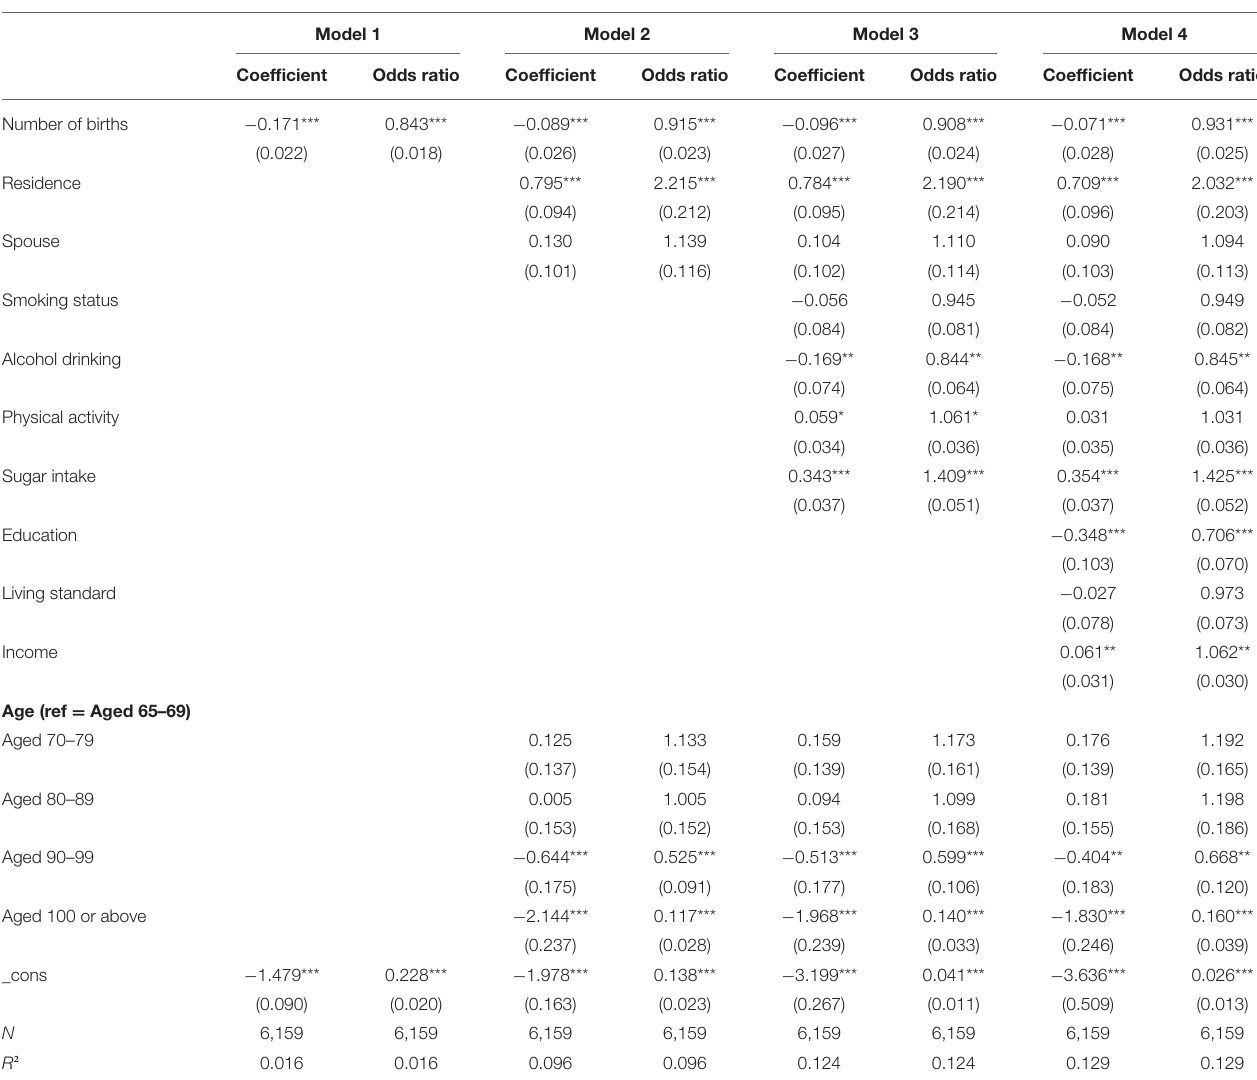
TABLE 2 | Estimations of the effects of the number of births on diabetes in older